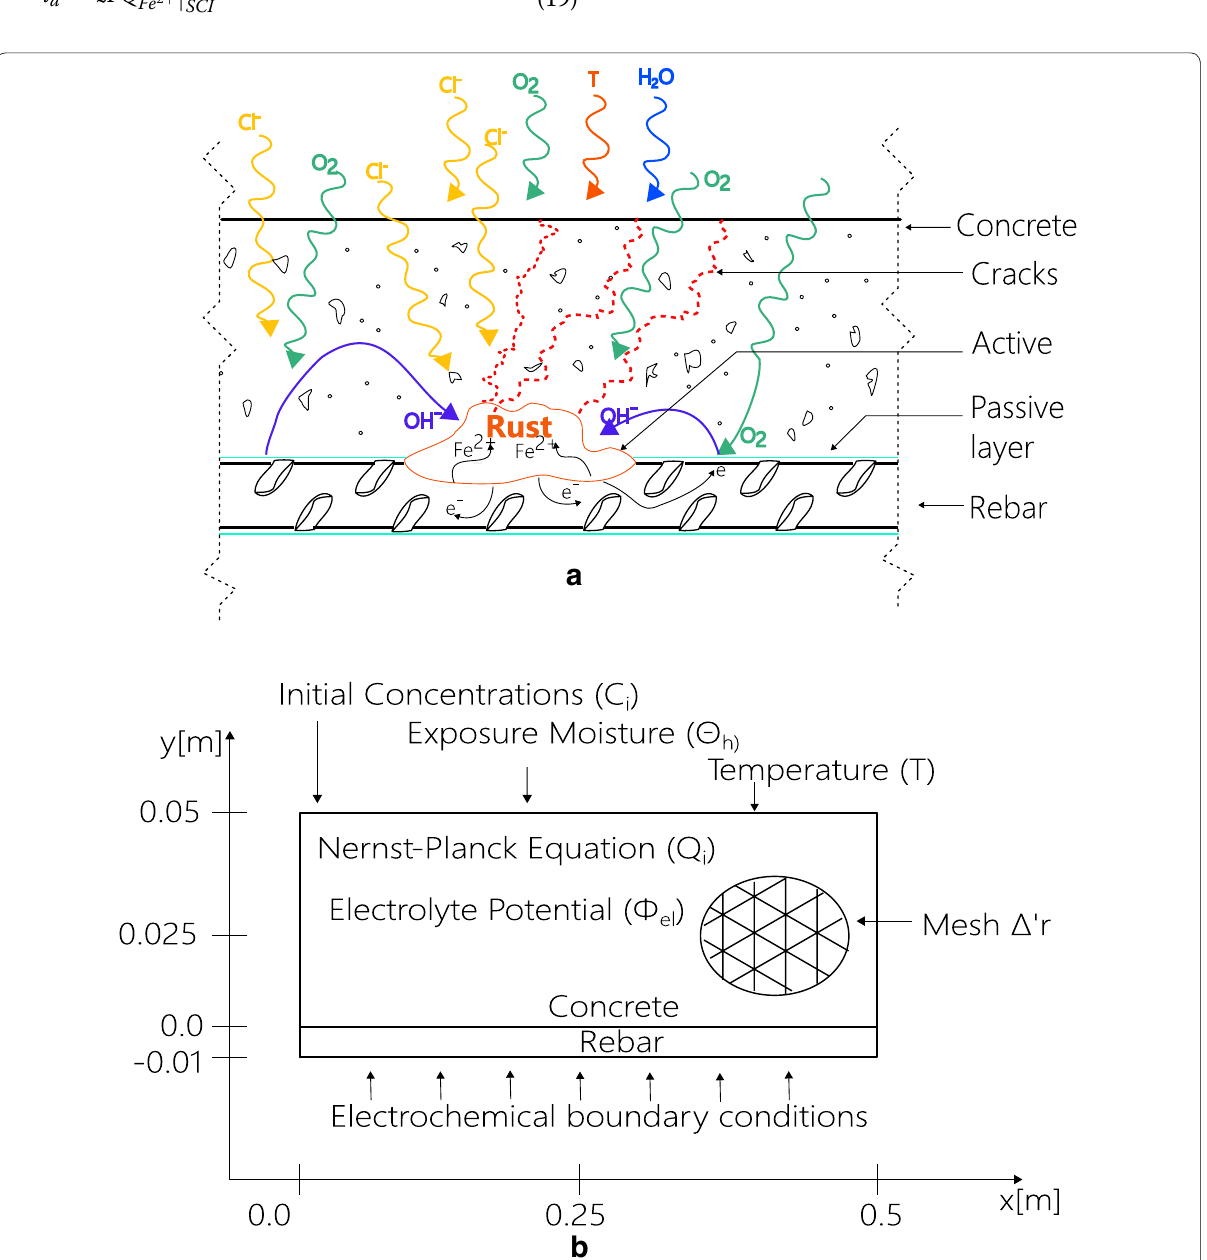
Fig. 5 a Anodic activation and rust generation on the rebar surface. b A simplified 2D model representing rebar and surrounding